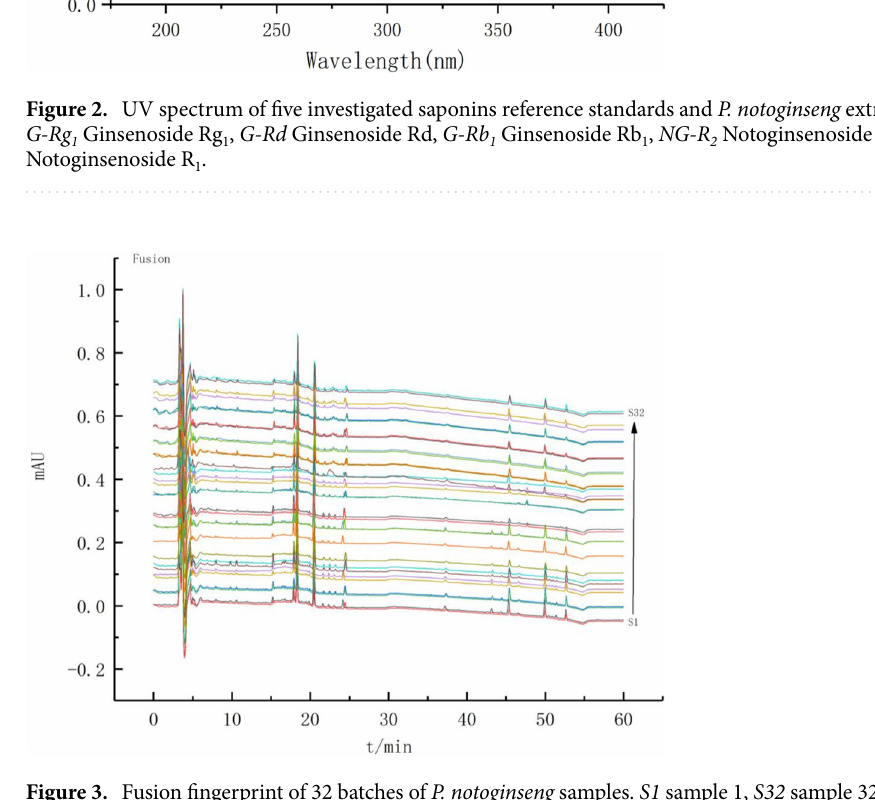
Figure 3. Fusion fingerprint of 32 batches of P. notoginseng samples. S1 sample 1, S32 sample